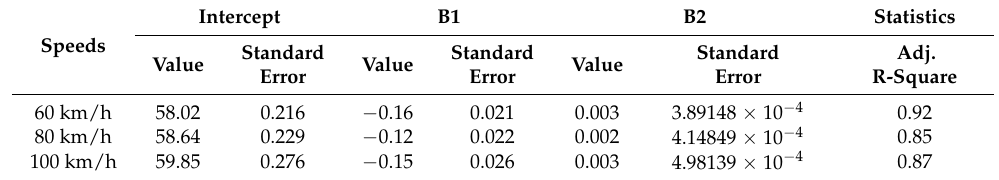
Table 8. Fitting results of driver’s visual workload intensity and TSIV under three-speed